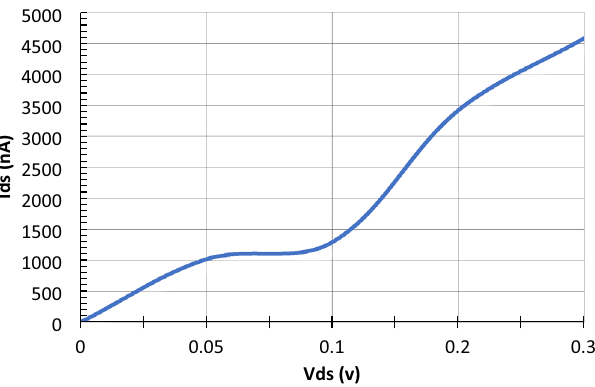
Figure 9. I–V curve of the bare G-FET sensor at V g = 1 V. Produced by Excel based on the data generated from QuantumATK software.